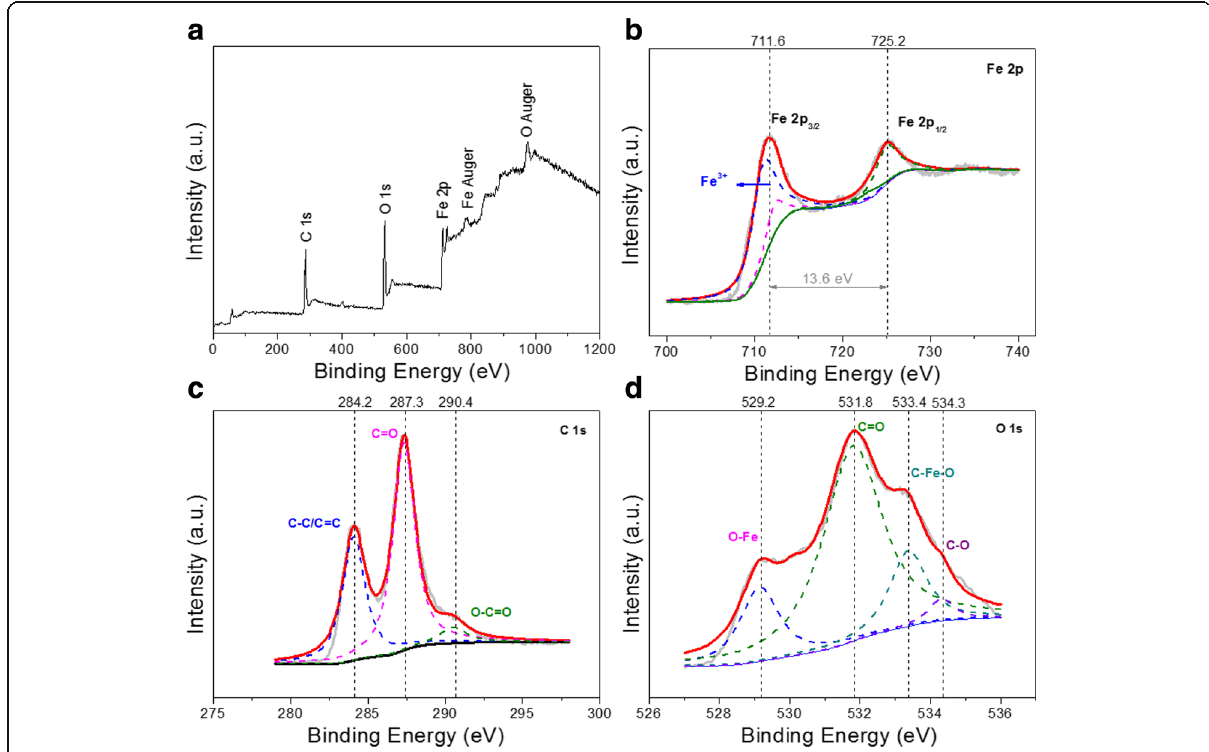
Fig. 2 a XPS survey spectra of Fe 2 O 3 /C, b Fe 2p, c C 1s, and d O 1s